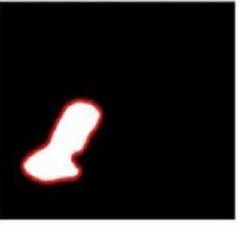
Fig. 12:Foreground Mask (Median